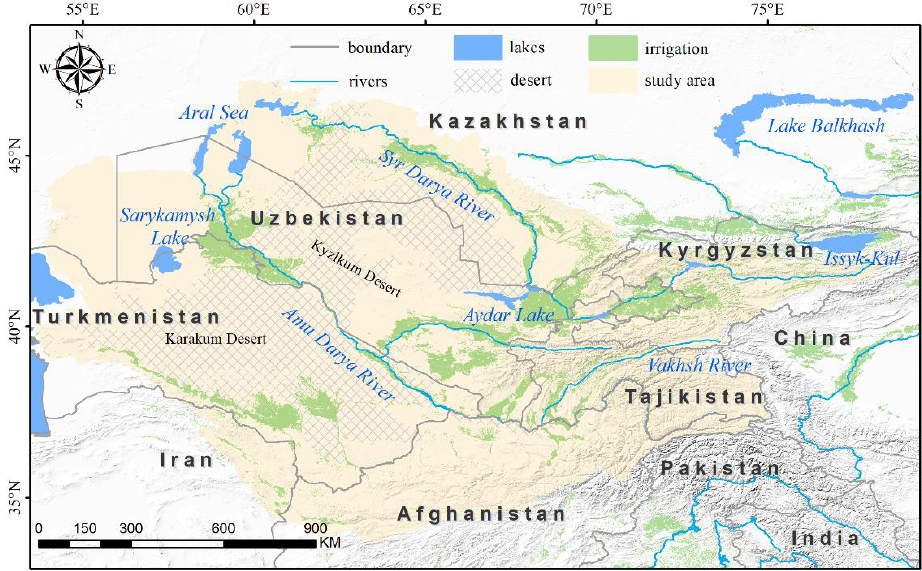
Figure 1. A map showing the location of the ASB. National boundary data were acquired from the National Administration of Surveying, Mapping, and Geoinformation with No. GS (2016) 1665.